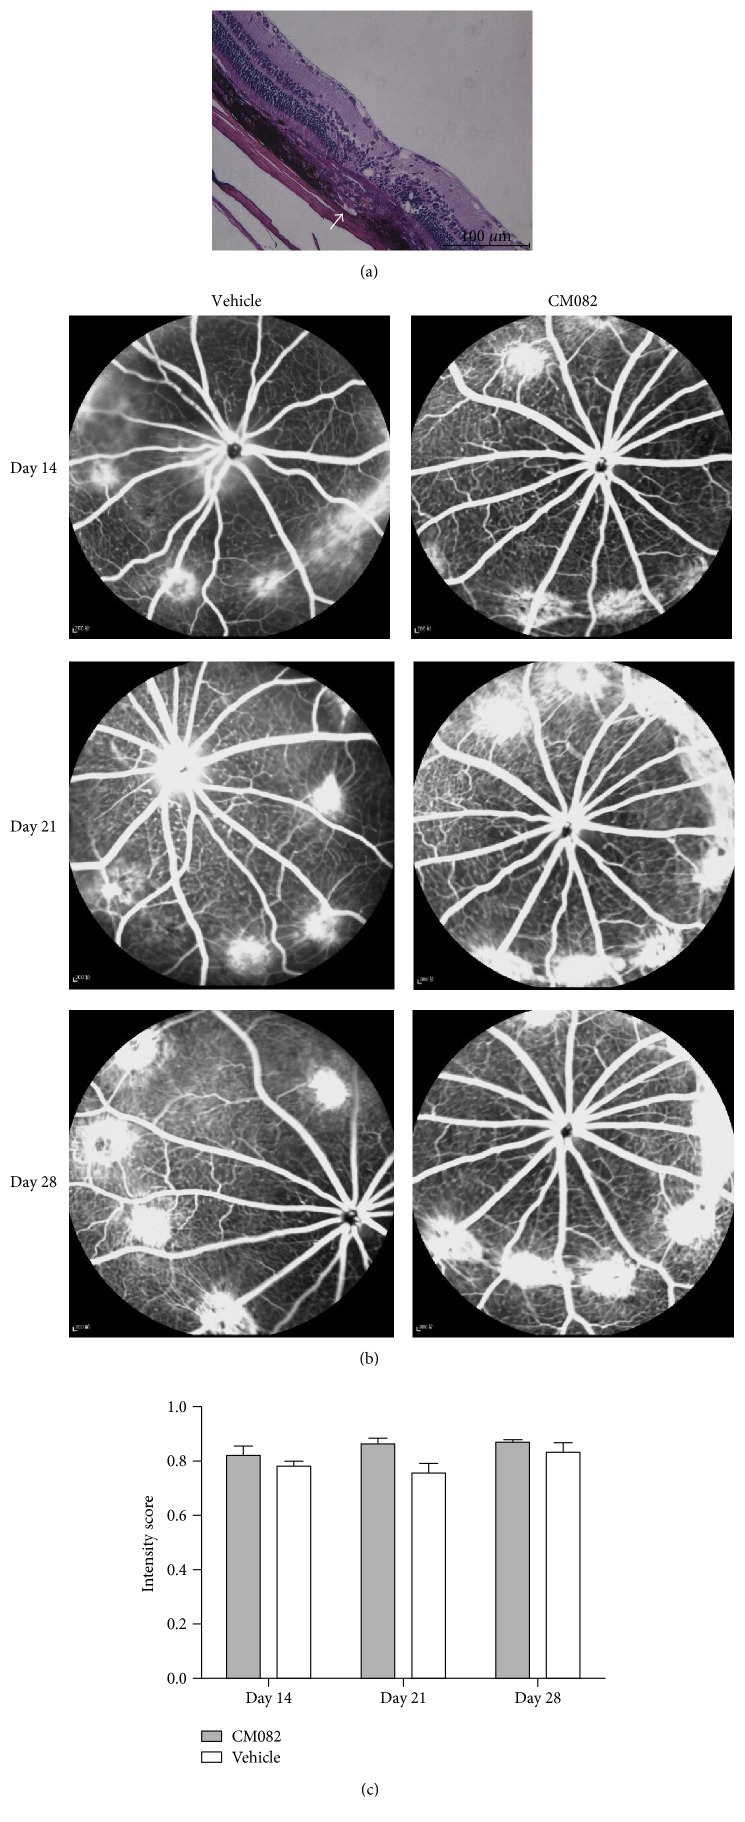
Histology and FFA results of CNV modeling. (a) Histology of CNV lesions stained with HE shows that CNV formation and broke the Brunch's membrane at 21 days after photocoagulation. Dome-like CNV complexes, consisting of fibrovascular tissue, retinal pigment epithelial cells, and pigment clumps, are shown and white arrow indicates the vessel lumina of neovascular. (b) FFA results showed fluorescein leakage of CNV in each group at day 14, 21, and 28 (7 days after CM082 treatment) separately. The signal intensity of capillary in background region was defined as “0” whereas the signal intensity of the main branch of the retinal vein was defined as “1”. (c) There is no significant difference between the intensity score of leakage in each group at day 14, 21, and 28 (p > 0.05). Scale bar, 100 μm.